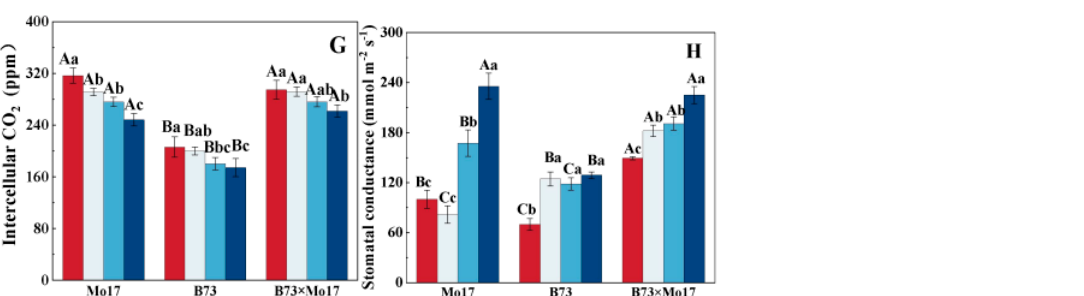
Figure 3. Effect of Mn deficiency on photosynthetic pigment contents and photosynthetic gas exchange parameters of maize seedling leaves. Chlorophyll a ( A ), chlorophyll b ( B ), chlorophyll a+b ( C ), carotenoid contents ( D ), photosynthetic rate ( E ), transpiration rate ( F ), intercellular CO 2 ( G ), stomatal conductance ( H ). According to the LSD test, different capital letters: significant difference between varieties ( p < 0.05); different lowercase letters: significant difference between MnSO 4 treatments ( p < 0.05). Data are expressed as the mean of three replicates.